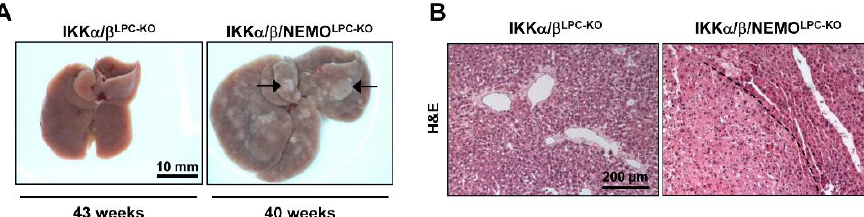
Figure 6. NEMO deletion induces hepatocarcinogenesis in mice lacking liver parenchymal IKK α / β expression. ( A ) Representative macroscopic pictures of 37–43 weeks-old IKK / LPC-KO , and IKK / /NEMO LPC-KO livers (n = 5). ( B ) H and E staining of liver paraffin sections of old IKK / LPC-KO